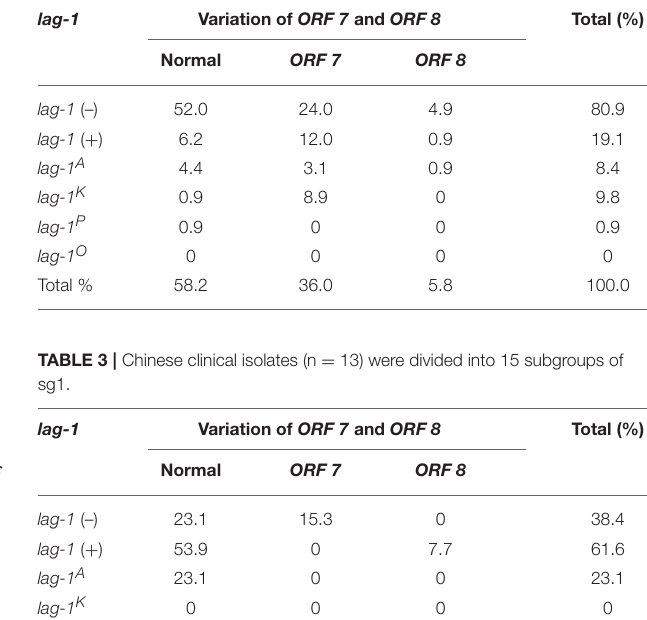
TABLE 1 | Japanese clinical isolates ( n = 206) were divided into 15 subgroups of sg1. lag-1